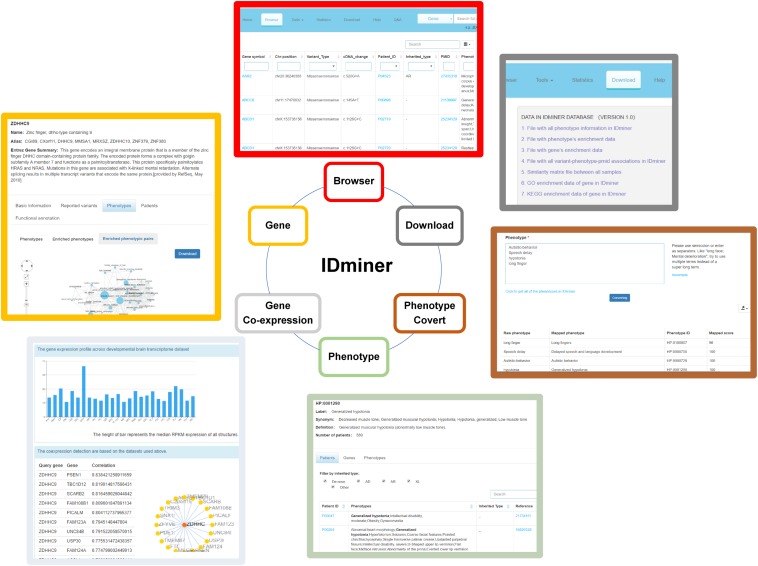
The illustration of functional modules of IDminer database. The six functional modules of IDminer: Brower, Genes, Gene co-expression, Phenotype, Phenotype convert, and Download.